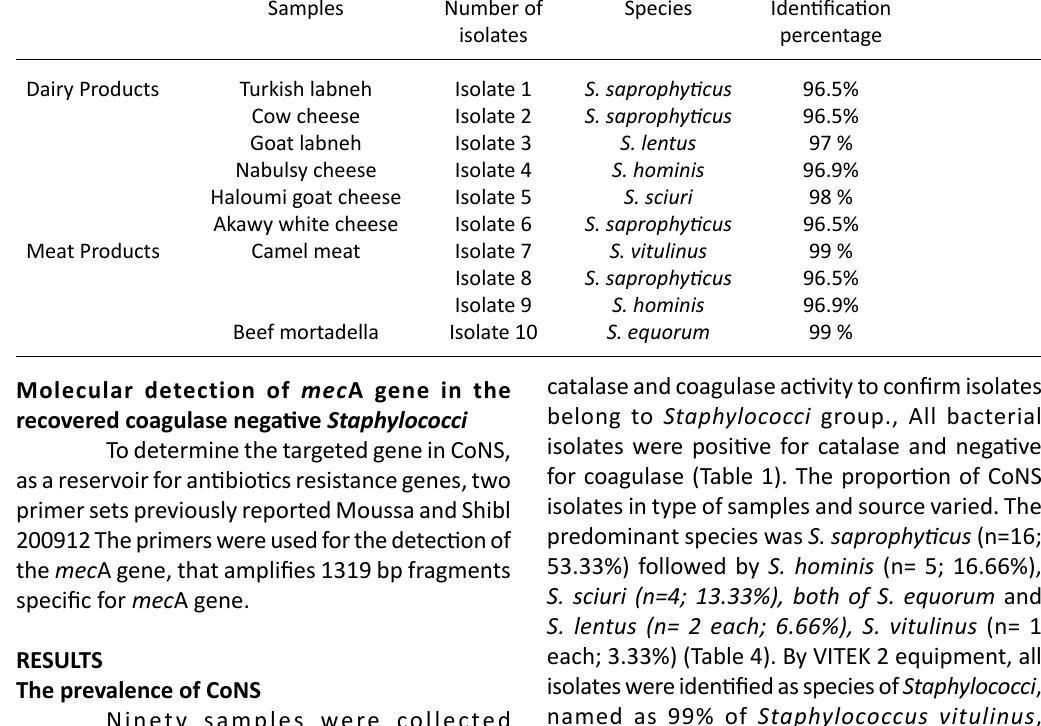
Table 2. Identification of bacterial isolates from dairy and meat products with VETIK2 system